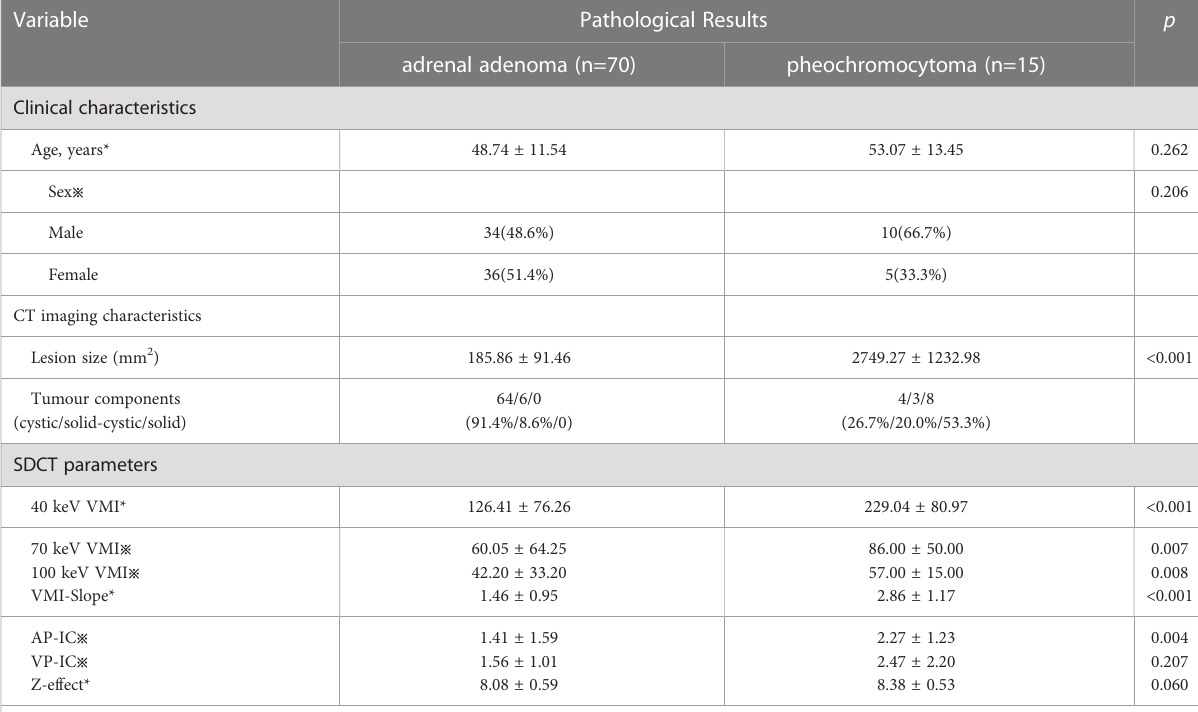
TABLE 1 Clinical characteristics, imaging characteristics, pathological results and SDCT parameters based on differentiating between pheochromocytoma and adrenal adenoma.